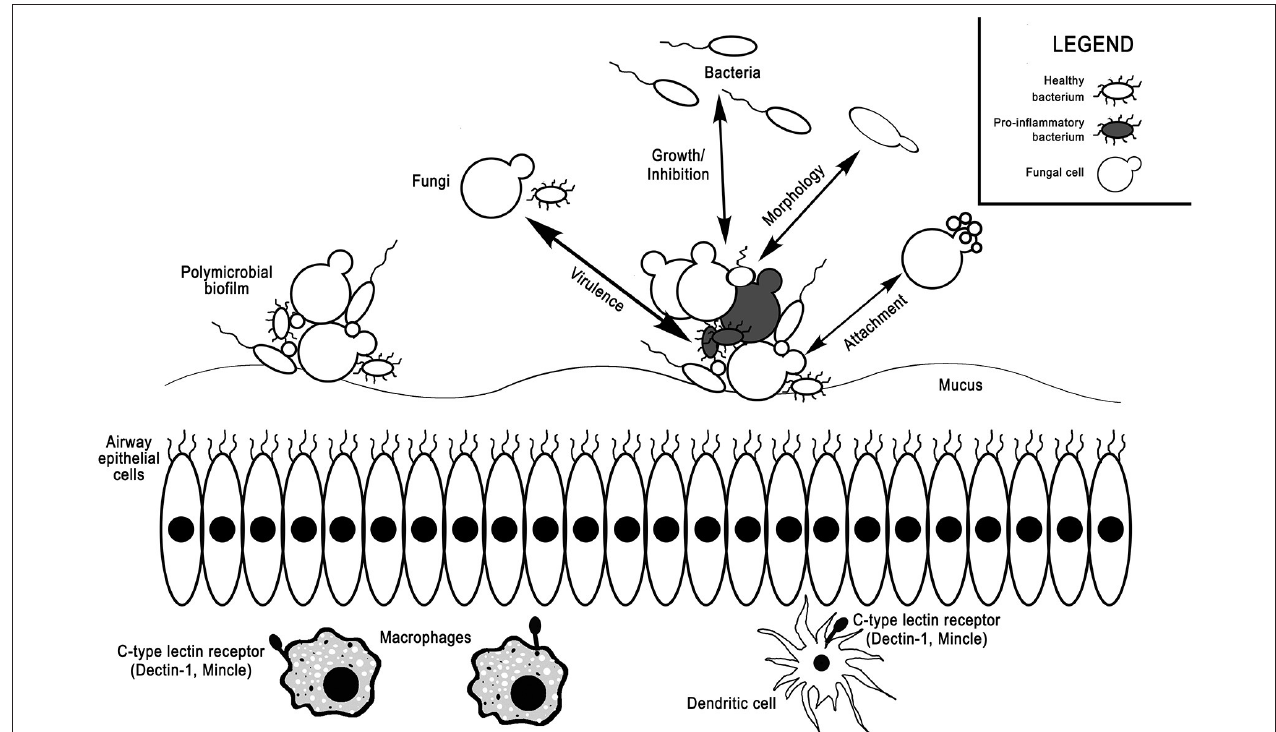
FIGURE 1 | Interactions between the bacterial microbiome, mycobiome, and host immune system in the airways. Bacteria and fungi coexist in mucosa-attached polymicrobial biofilms in the airways. Fungi can selectively induce or inhibit growth of various bacterial taxa, increase bacterial virulence factors, alter bacterial morphology, or act as attachment sites for bacteria. Vice versa, bacteria can also alter fungal growth, virulence, morphology, and attachment. C-type lectin receptors on macrophages and dendritic cells, such as dectin-1 and Mincle, can sense fungi and mediate host inflammatory responses.